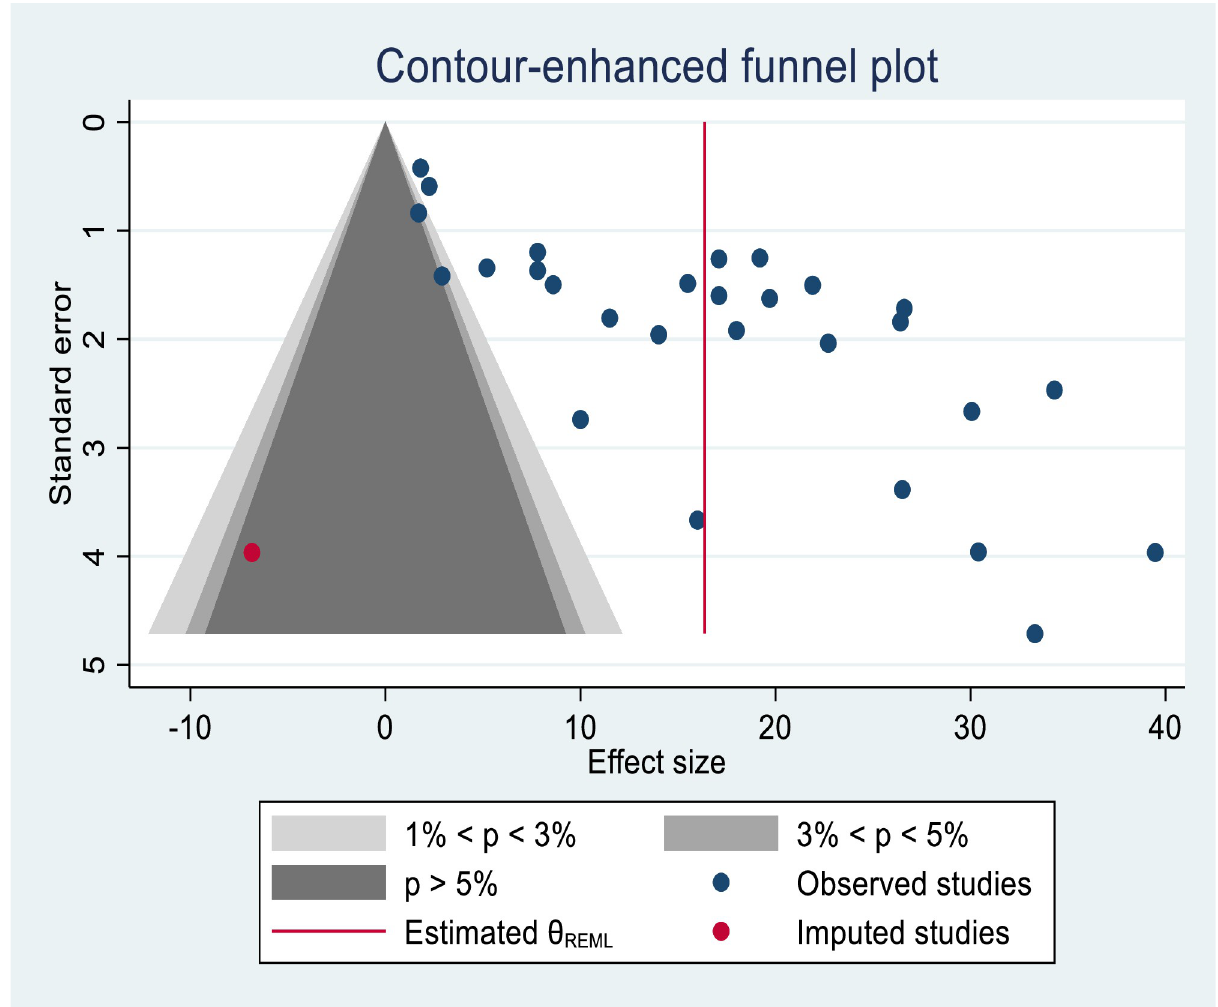
Fig 3. Funnel plot, and trim and fill result of the analysis of included studies.